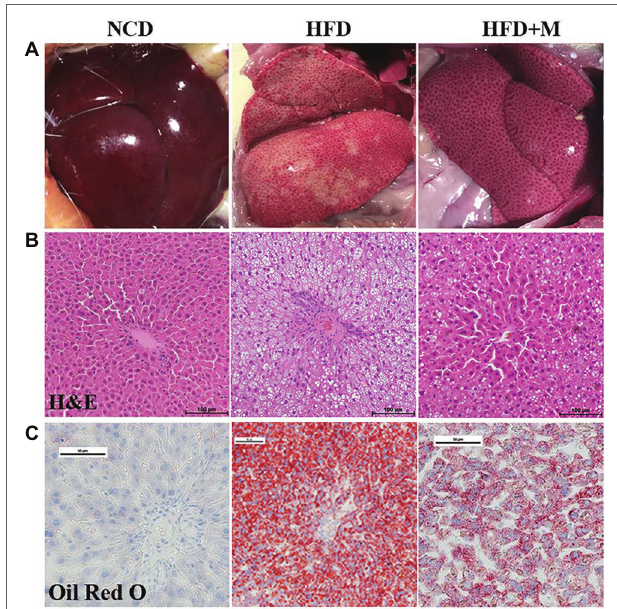
FIGURE 6 | Changes in hepatic steatosis after fecal microbiota transplantation. (A) Photos showing liver morphology. (B) H and E staining of liver section. Scale bars, 100 μ m. (C) Liver Oil Red O staining. NCD, Normal Chow Diet rats; HFD, HFD rats; HFD + M, HFD rats received fecal microbiota transplant from HFD-T monkeys. Scale bars, 50 μ m.